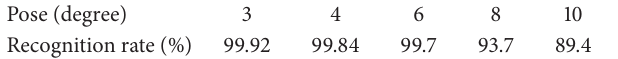
Table 1: Parameter setting of the proposed algorithm.